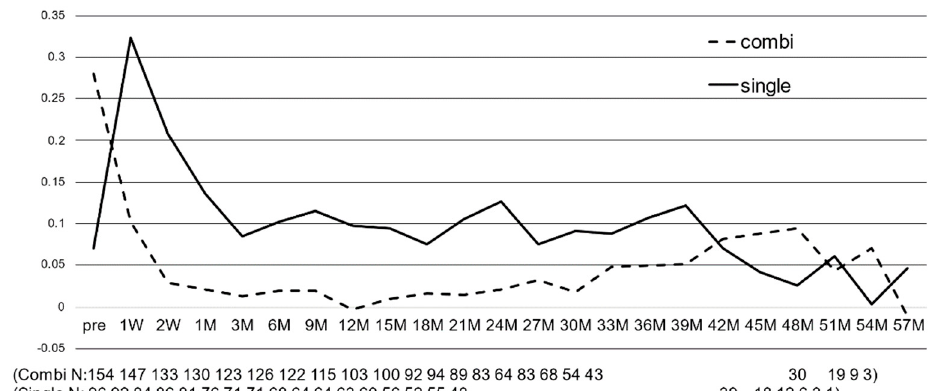
Repeated ANOVA; BCVA significantly improved from 1 to 30 months postoperatively in the combined Figure 7 . Postoperative changes in BCVA (logMAR) between single vs. combined cataract surgery. cataract group ( p < 0.05). In the trabectome ® alone group, BCVA significantly decreased during Repeated ANOVA ; BCVA signi fi cantly improved from 1 to 30 months postoperatively in the com- the first postoperative week ( p < 0.001), but the significant difference from the preoperative period bined cataract group ( p < 0.05). In the trabectome ® alone group, BCVA signi fi cantly decreased during disappeared from 2 weeks to 57 months the fi rst postoperative week ( p < 0.001), but the signi fi cant di ff erence from the preoperative period disappeared from 2 weeks to 57 months postoperatively.